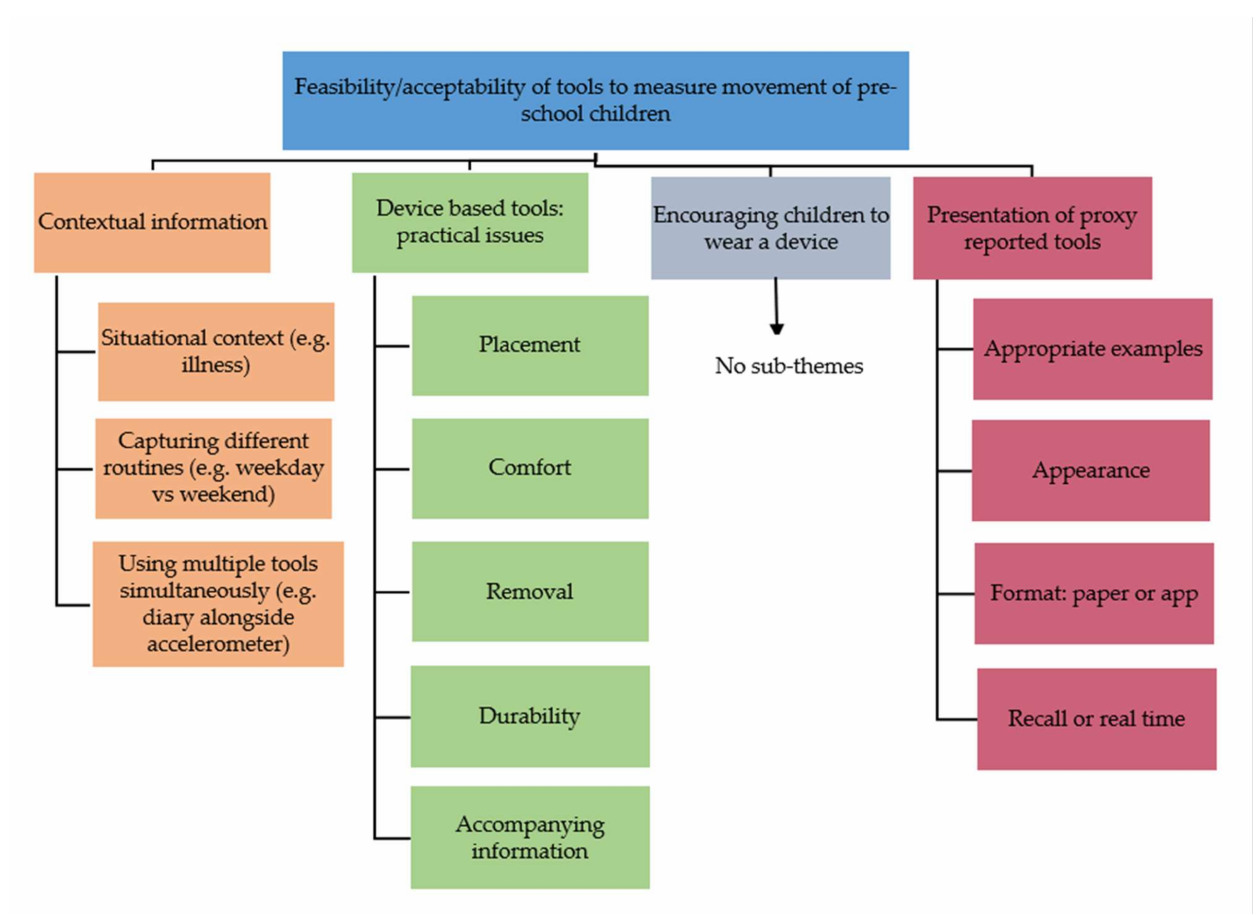
Figure 1. Overview of key themes and subthemes.